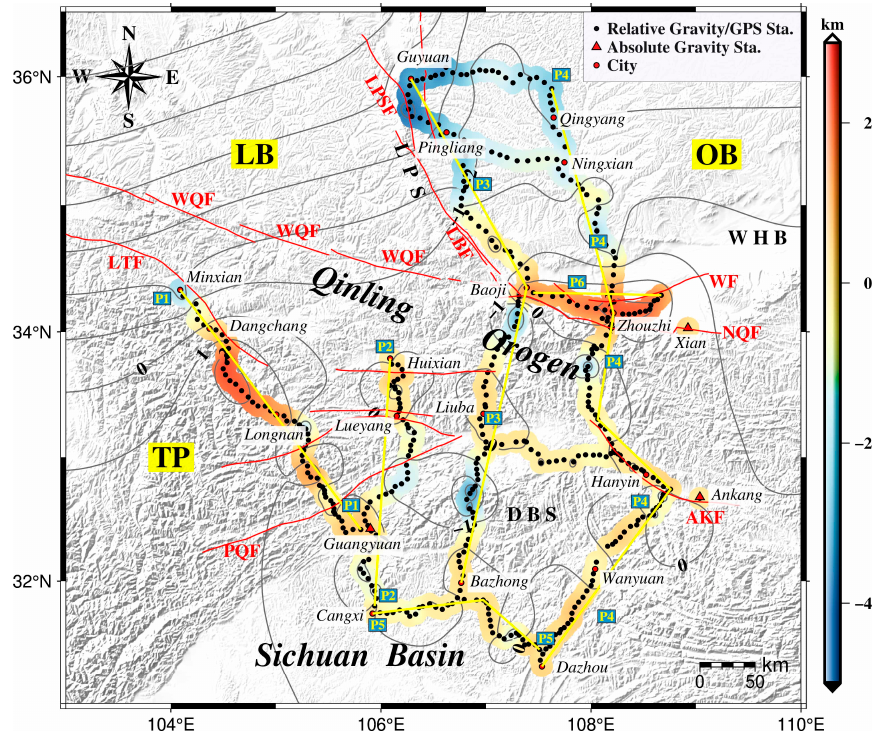
Figure 7. The isostatic anomaly map in the Qinling area. Abbreviations are the same as those used in Figure 1.